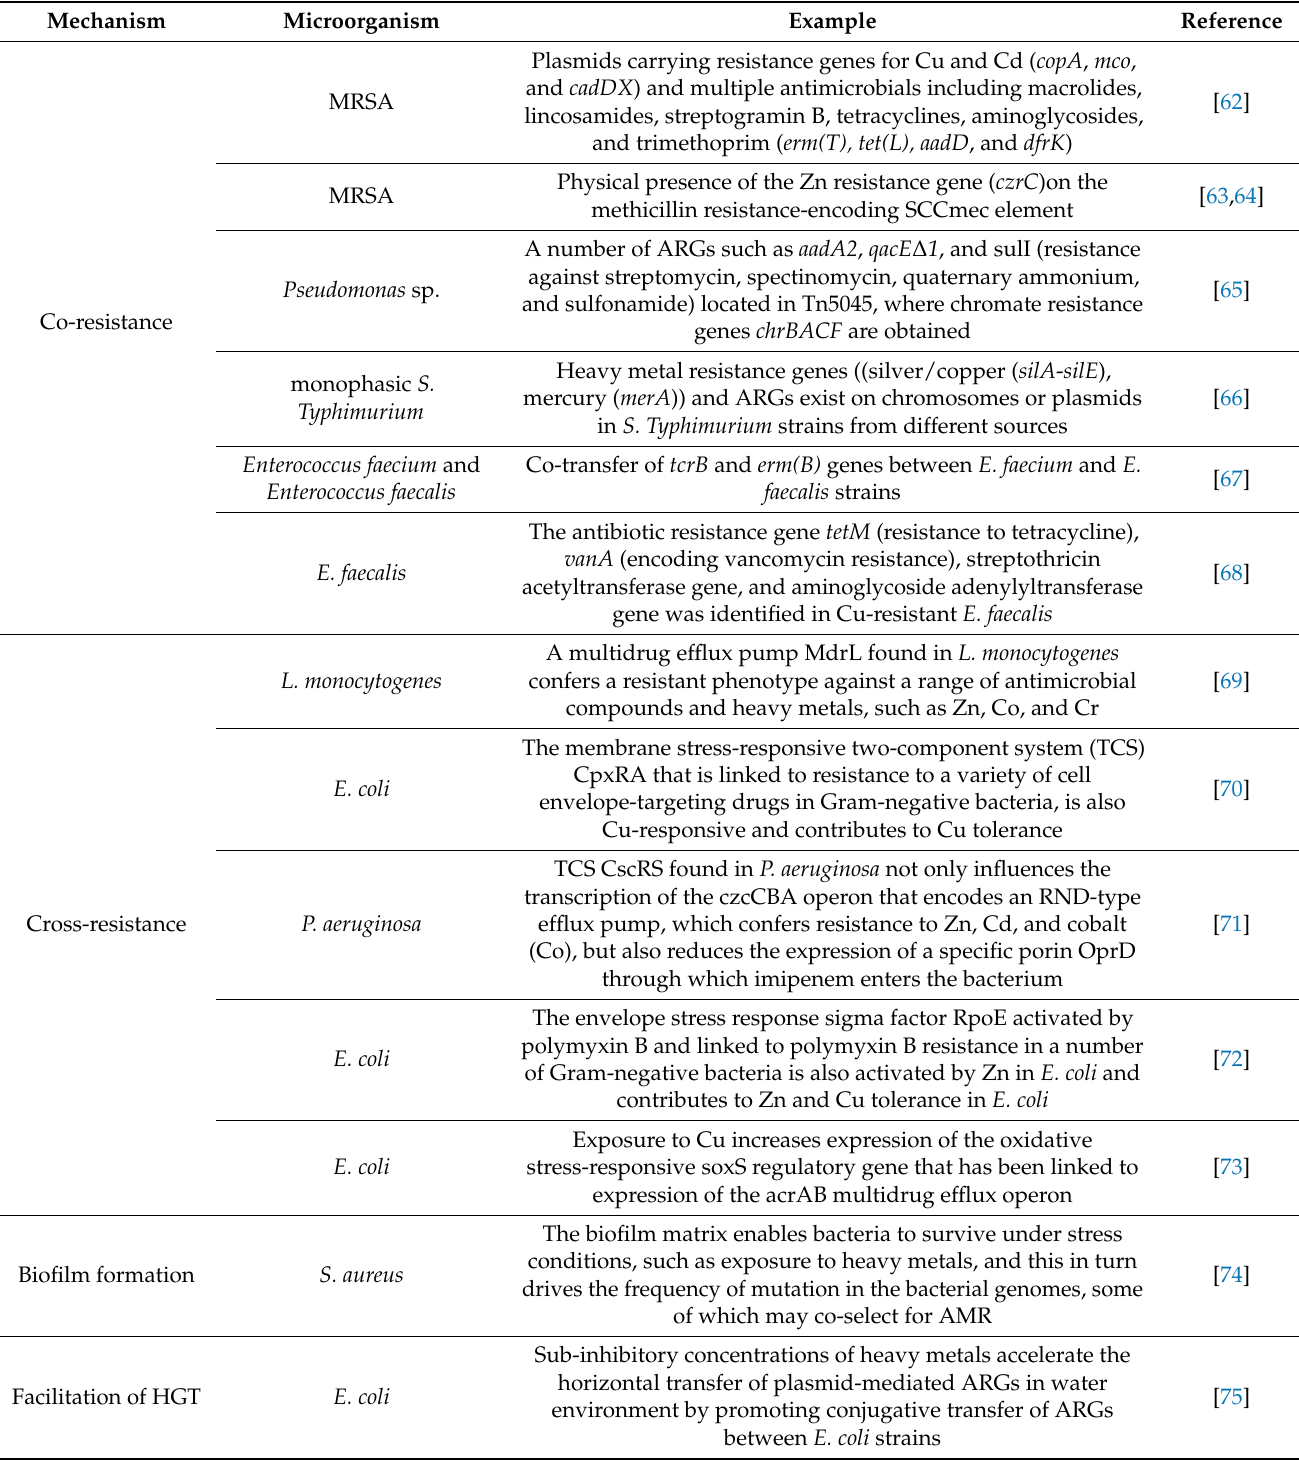
Table 3. Mechanisms of co-selection of AMR by heavy